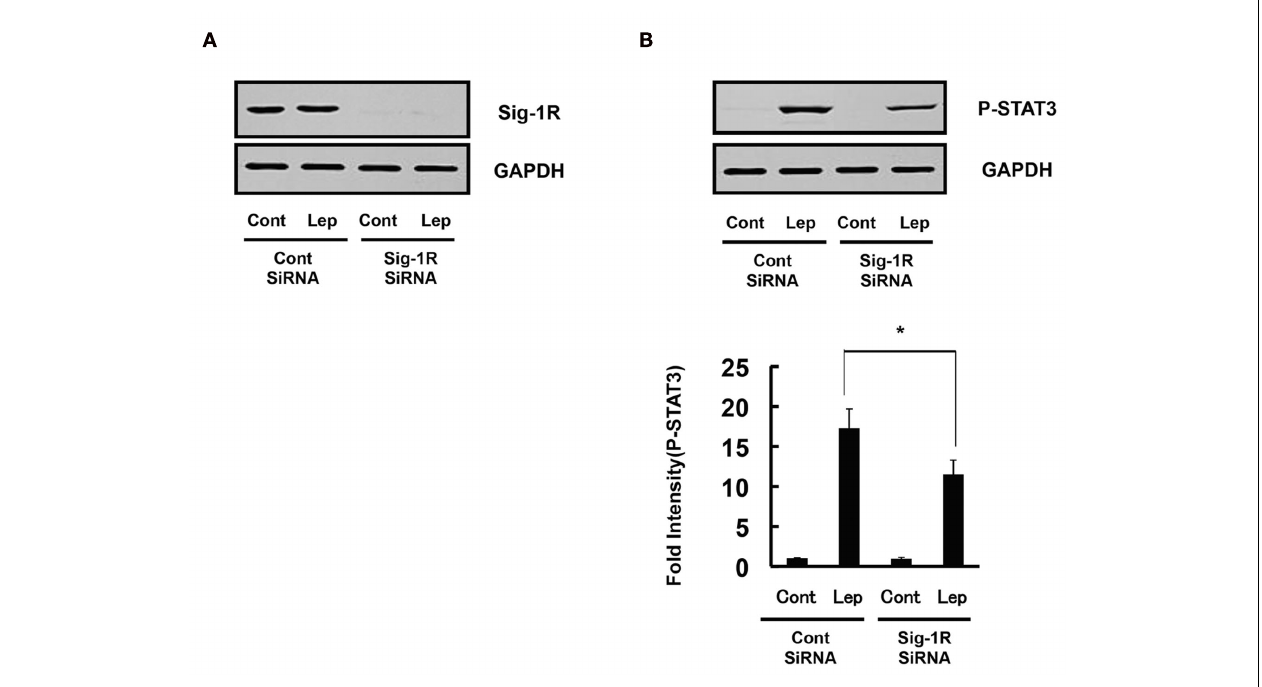
(B) Sig-1R siRNA decreased leptin-induced STAT3 phosphorylation compared with control siRNA. HEK293-Ob–Rb cells were transfected with 50nM siRNA and treated with leptin (0.5 μ g/mL) for 15min. Western blot analysis was then performed. * P < 0.05 compared with control siRNA.